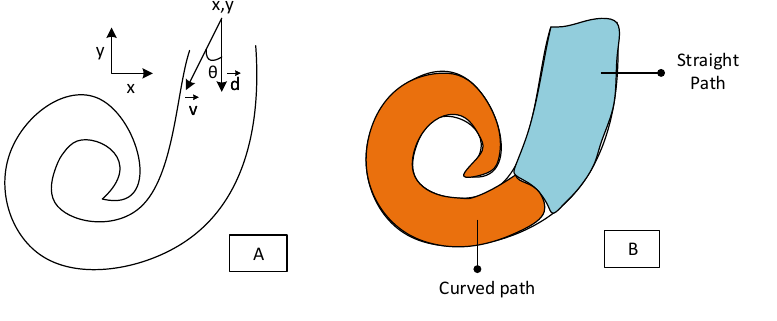
Figure 7. ( A ) Electrode array insertion configuration. ( B ) Division of insertion path into straight and curved